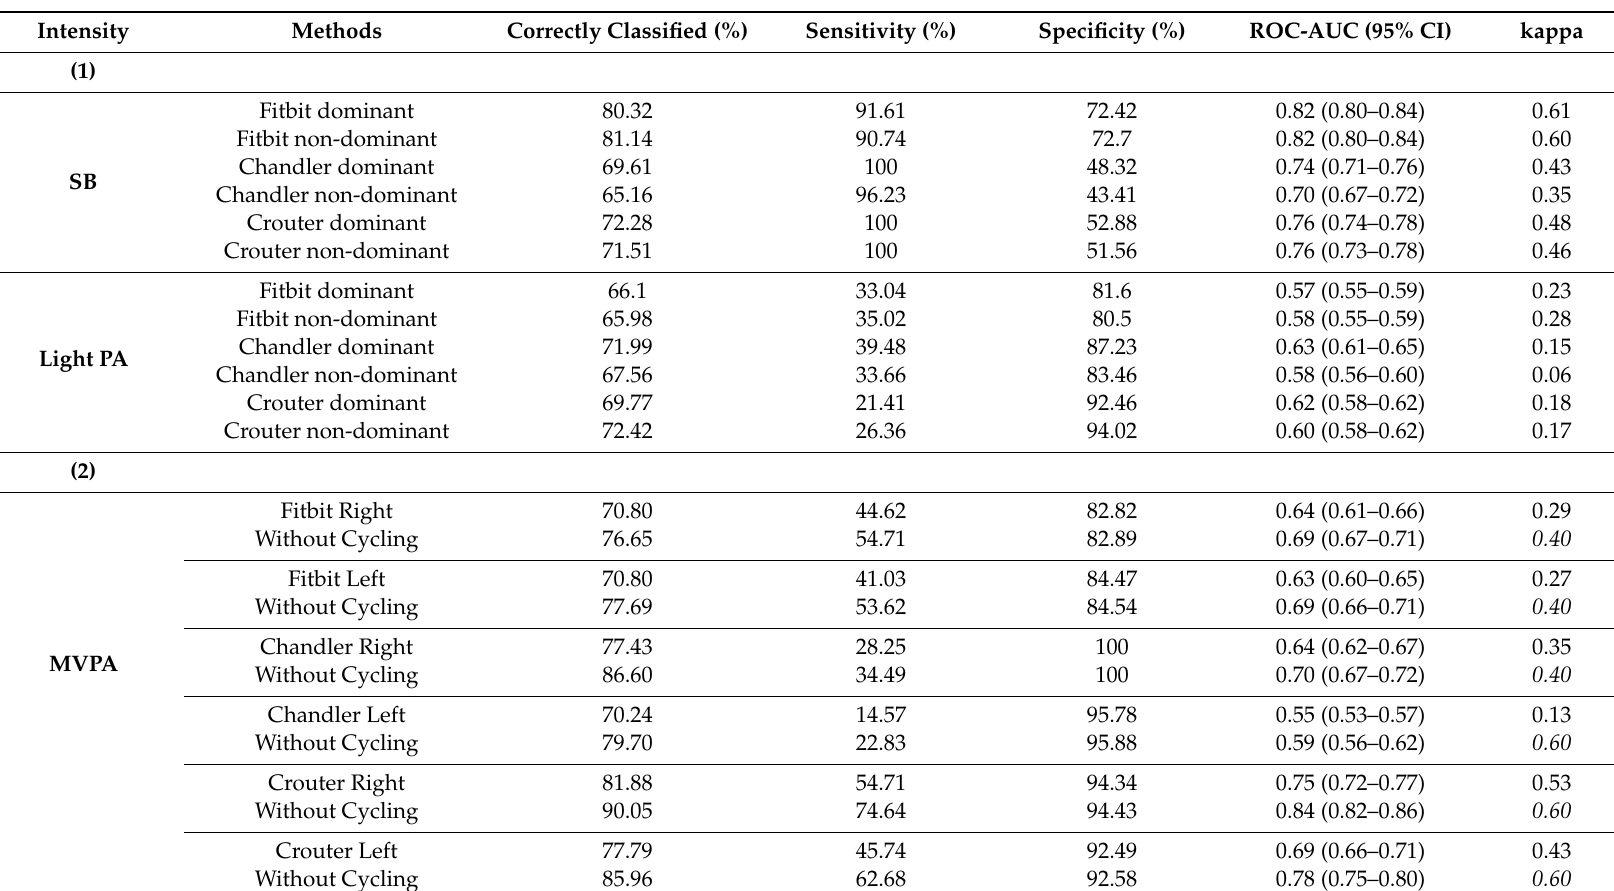
Table 3. (1) Agreements in SB and Light PA intensity classifications for four methods, Kappa, ROC-AUC, Sensitivity, and Specificity; (2) Agreements in MVPA intensity classifications for four methods, Kappa, ROC-AUC, Sensitivity, and Specificity with / without cycling